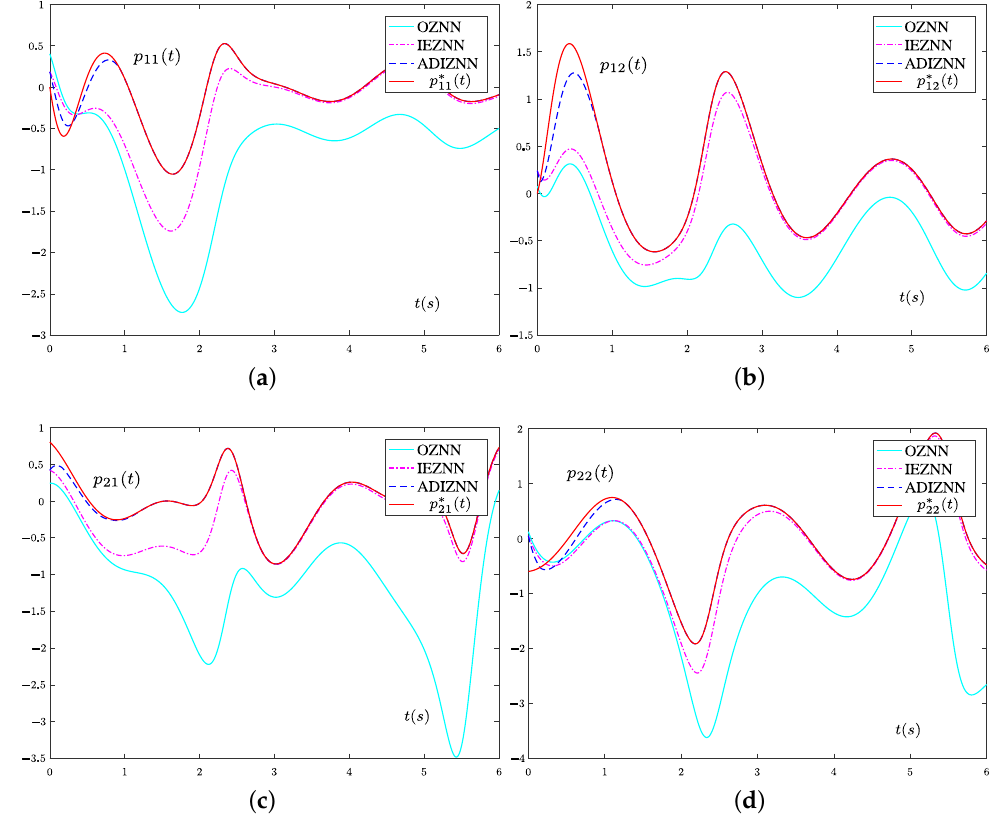
Figure 2. State trajectories of OZNN (9), IEZNN (12) and ADIZNN (19) for the DSE with (35) under the linear noise z i ( t ) = t /4 + 4. ( a ) State trajectory of p 11 ( t ) . ( b ) State trajectory of p 12 ( t ) . ( c ) State trajectory of p 21 ( t ) . ( d ) State trajectory of p 22 ( t )